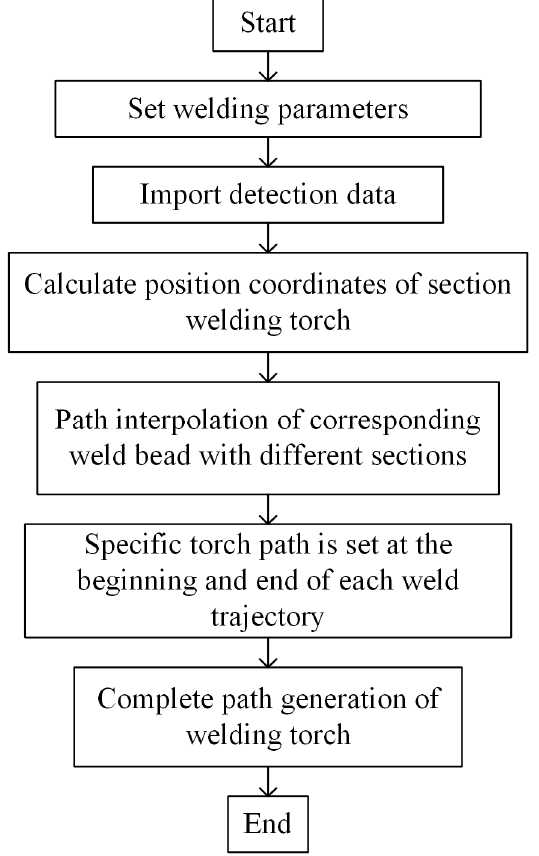
Figure 8. The workflow of technological process.